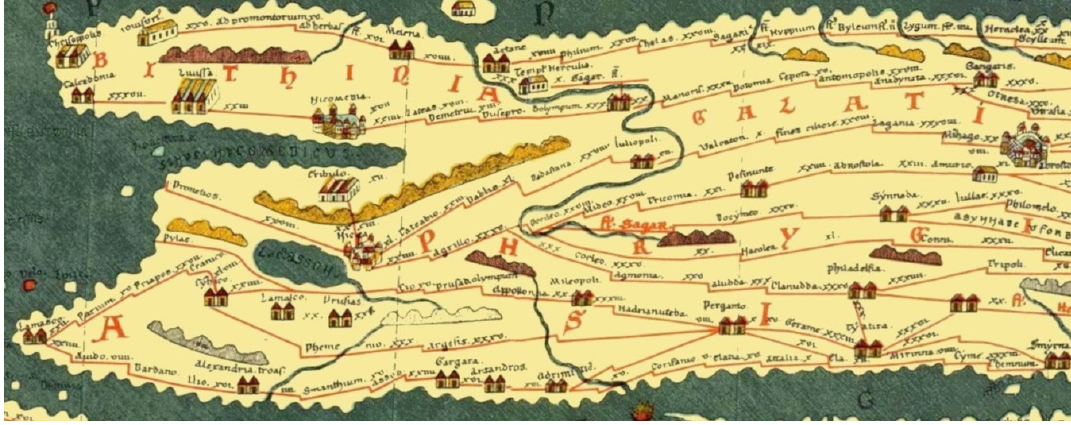
Figure 5. Section of segment IX of the Tabula Peutingeriana (after K. Miller [37]).